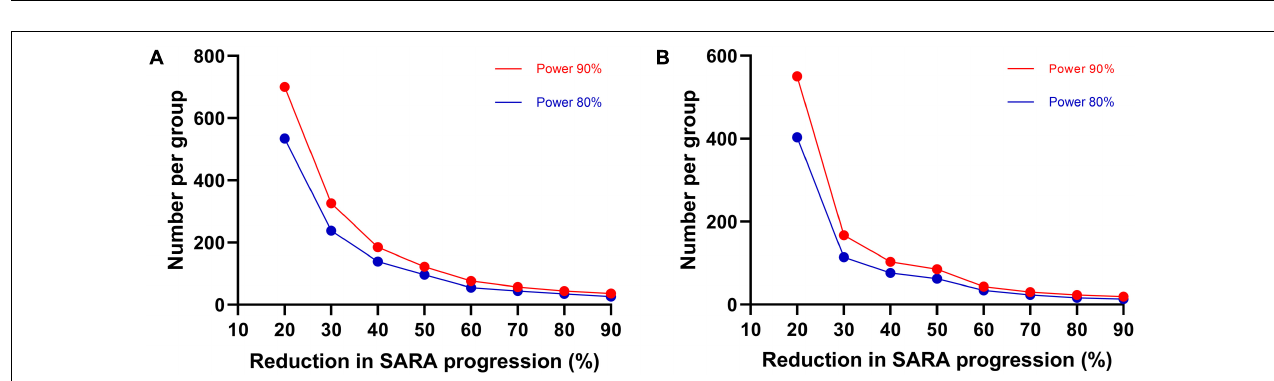
FIGURE 3 | Sample size estimates. Required sample size per group in two-armed clinical trial for 1-year (A) and 2-years duration (B) , to detect various differences in SARA progression as a function of treatment efficacy and a statistical power of 80 and 90%.